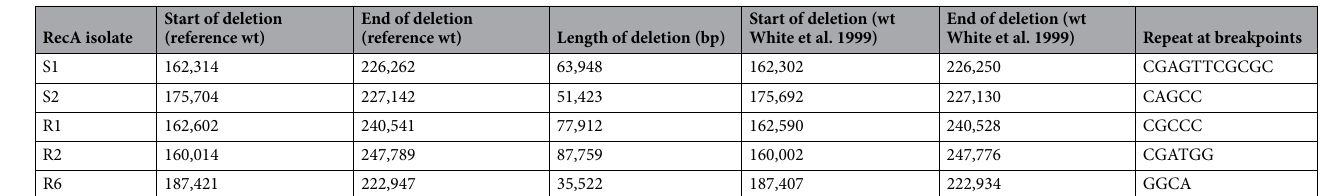
Table 2. Coordinates (in bp) of recA deletions in D. radiodurans reference wt chromosome II, located with DNAdiff program, and direct repeats found at breakpoints. Start and end of deletion are reported as starting